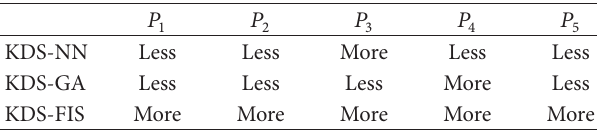
Table 2: Performance dimension matrix of KDS-GA, KDS-NN, and KDS-FIS for sensor data.